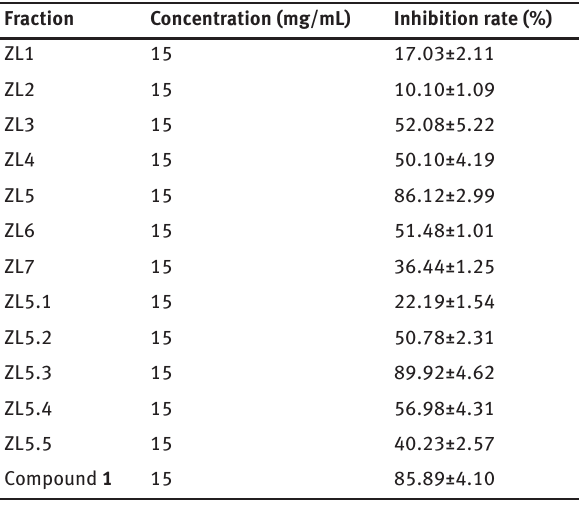
Table 2: Inhibitory effects of different fractions from EtOAc fraction on